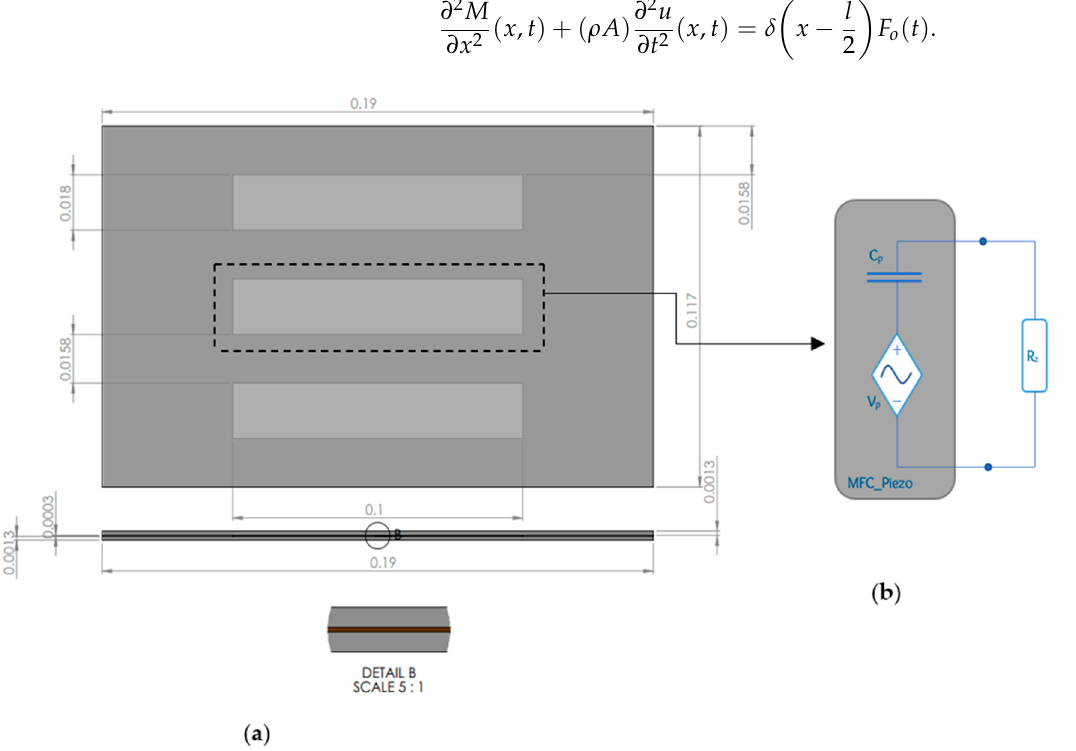
Figure 1. ( a ) The MFCs piezoelectric transducers are laminated in three parallel layers between two epoxy glass fiber composites. The model is meant to represent dimensionally the laminated beam that was taken into consideration for this work. ( b ) A schematic representation of the piezoelectric transducer’s electrical circuit, including the resistor that is attached externally.